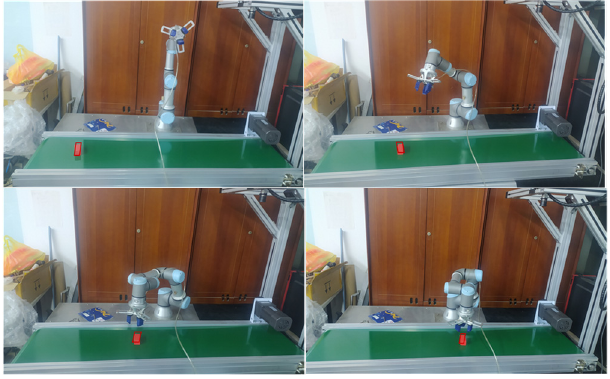
Figure 12. Experimental environment tracking and capturing camera images.